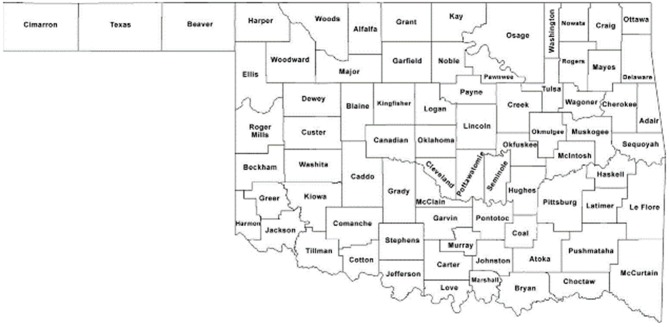
Oklahoma county map.